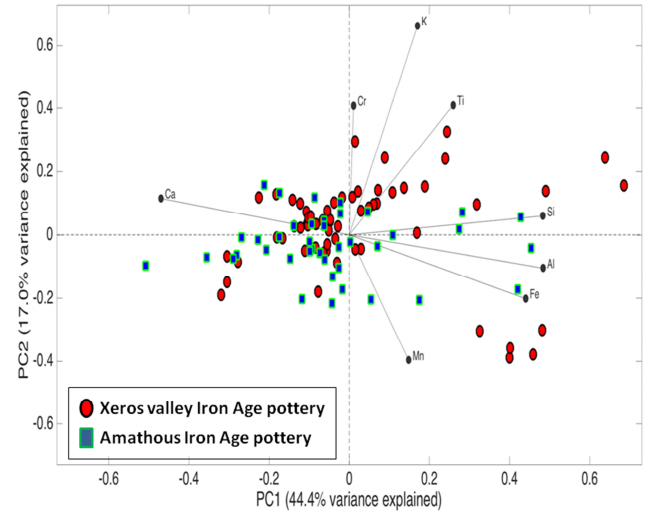
Figure 18. The pXRF and statistical analysis of Iron Age and Late Antique pottery from the Xeros River valley (Principal Component Analysis by Andreas Charalambous).